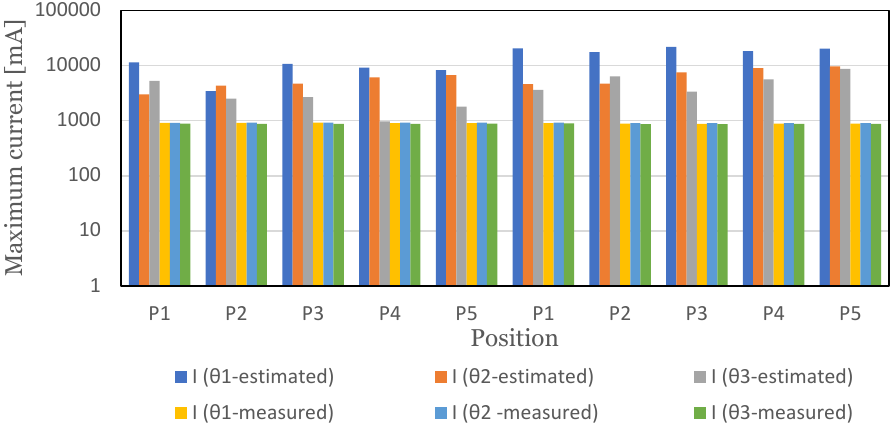
Figure 18. The result of the maximum current estimated and measured during test no. 5. The first five positions (P1 . . . P5) during the test were reached with the speed of 20% and a weight of 200 g, and the last five were reached with a speed at 35% and 300 g of weight.